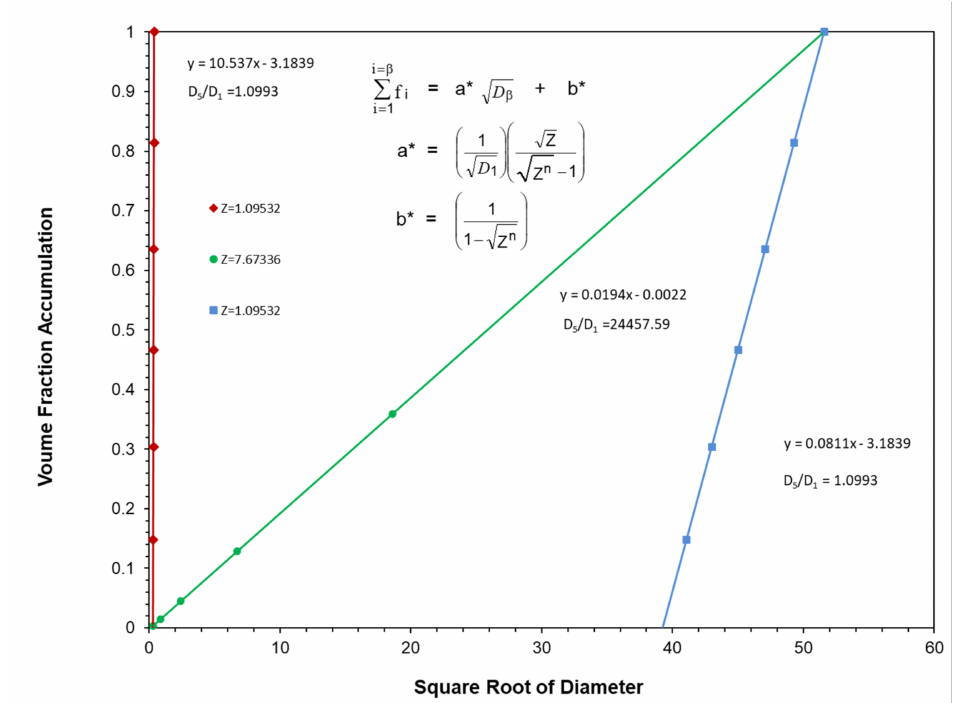
Figure 11. Volume fraction accumulation vs. square root of particle diameter for six particles at two different Z